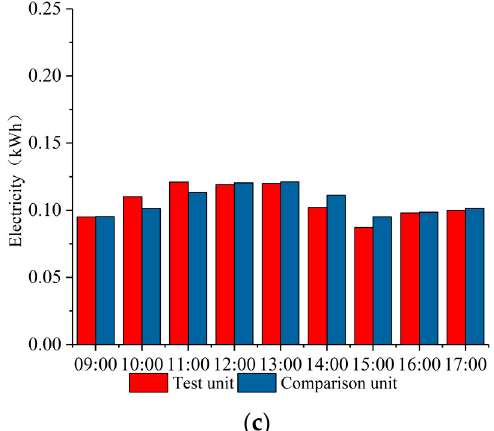
Figure 6. Air-conditioning electricity consumption on a ( a ) sunny day, ( b ) cloudy to sunny day, and ( c ) a cloudy day.